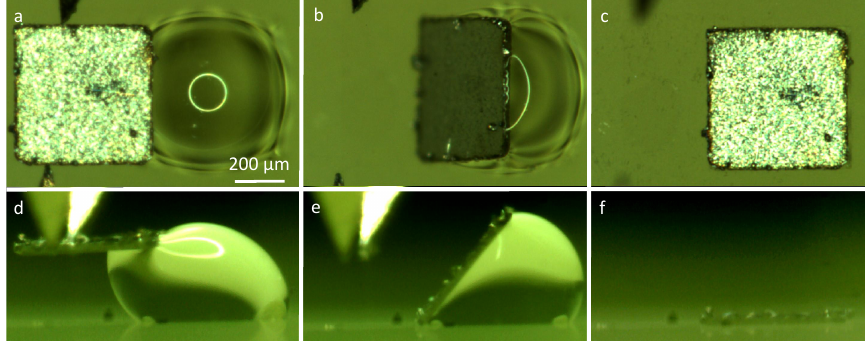
Figure 6. Top-view and side-view images of capillary self-alignment of a 500 µ m ˆ 500 µ m chip on a superhydrophobic patterned PDMS substrate (extracted from Supplementary Videos S1 and S2): ( a , d ) a chip was ready to be released with extreme large placement bias (470 µ m); ( b , e ) once the chip was released by a gripper, the chip was tilted and one edge was aligned to the edge of the pad; ( c , f ) the droplet evaporated and the chip was aligned with the